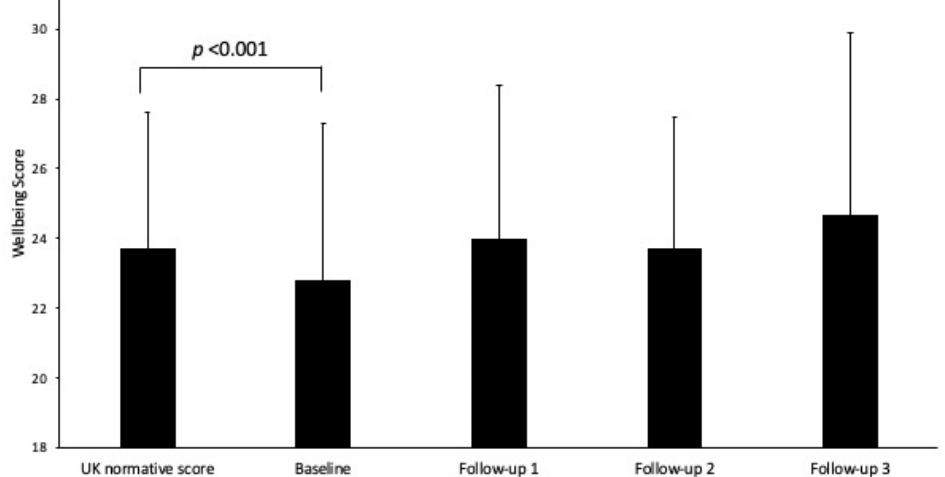
Figure 1. Mean ( ± SD) SWEMWBS normative scores and Green Gym attendee scores at baseline and follow up points.